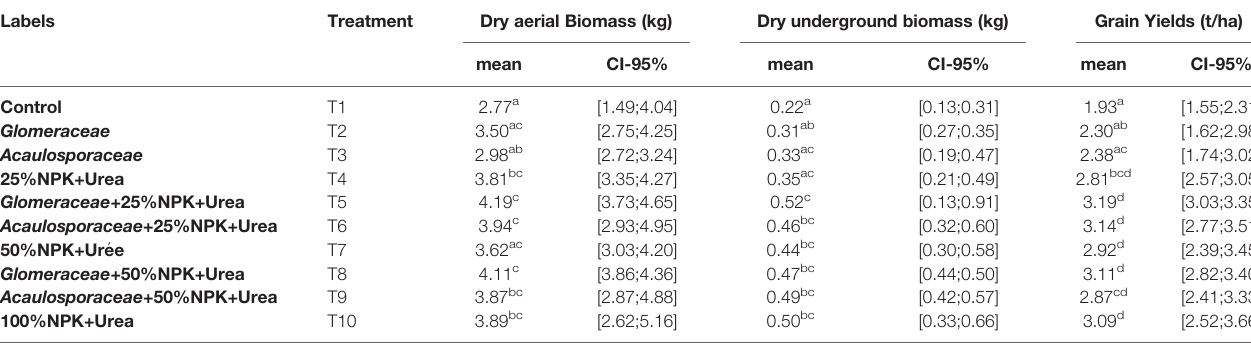
TABLE 5 | In fl uence of endogenous strains on the variables of biomass produced and grain yield according to the type of treatment in the fi eld.